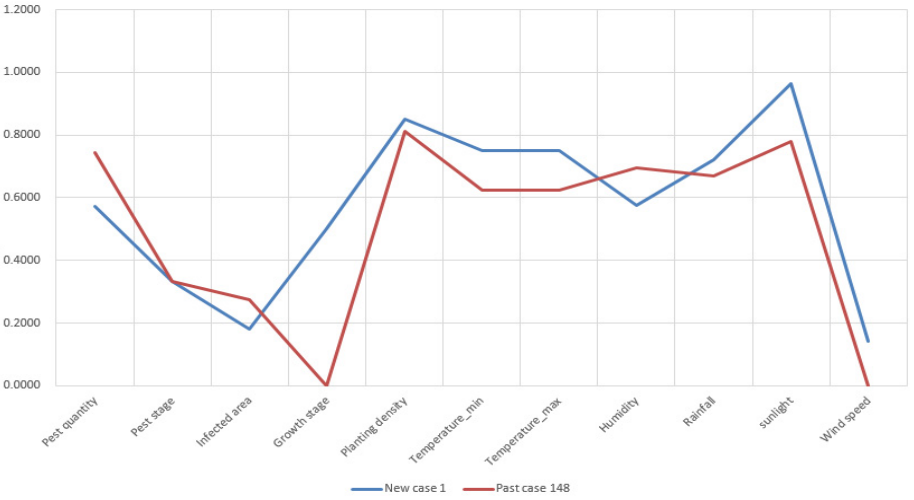
Figure A1. Attribute visualization of new case 1 and retrieved past case 148.